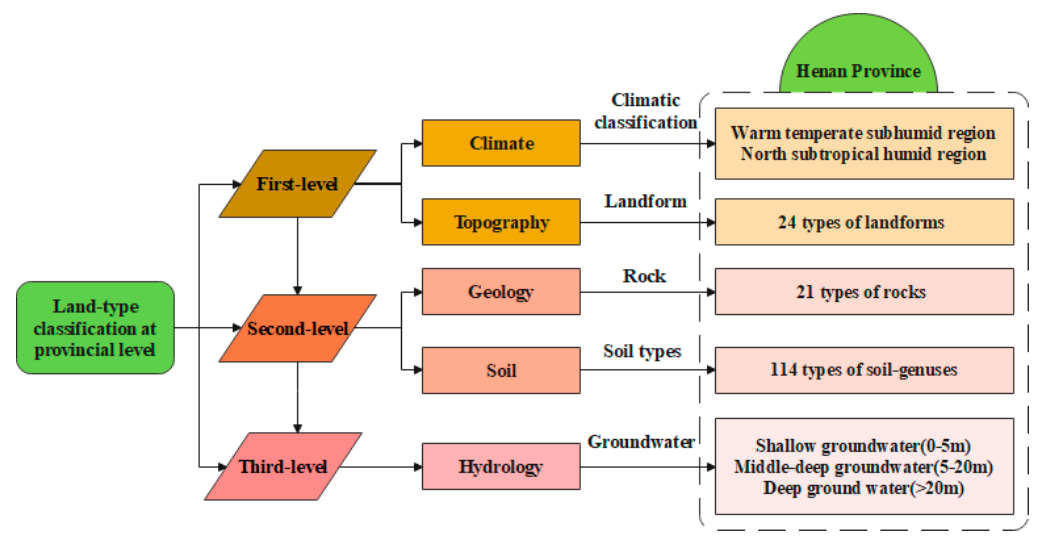
Figure 3. Land types classification system at the provincial level.